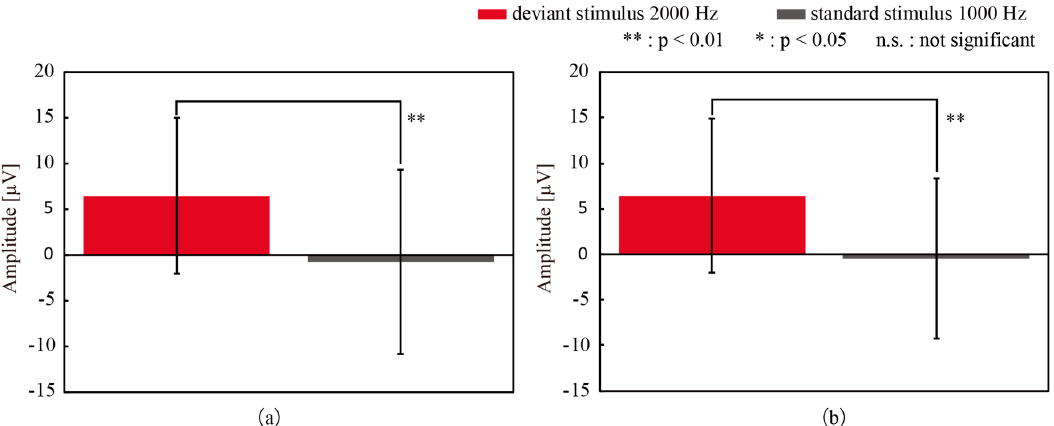
Figure 5. The amplitudes of EEG ( a ) 307 ms after the deviant and standard stimuli with CMEs and ( b ) 305 ms after the stimuli with wet electrodes. A significant di ff erence was found between the response to deviant and standard stimuli. Error bars: standard deviation.